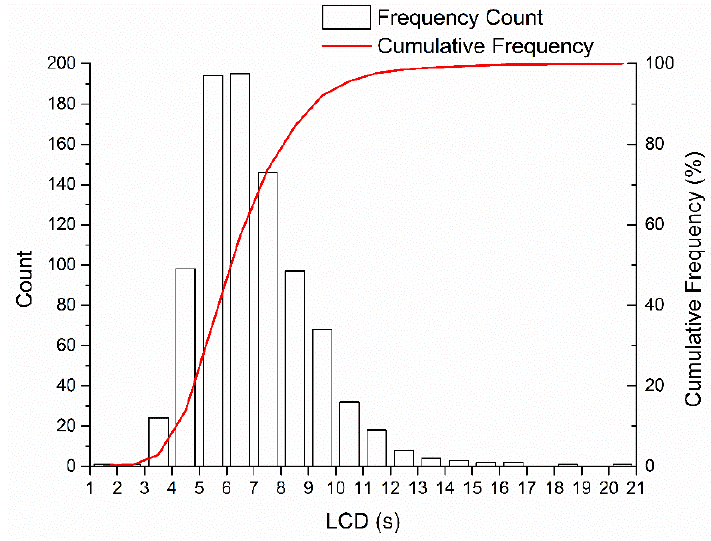
Figure 7. Lane-Change Duration ( LCD) distribution.